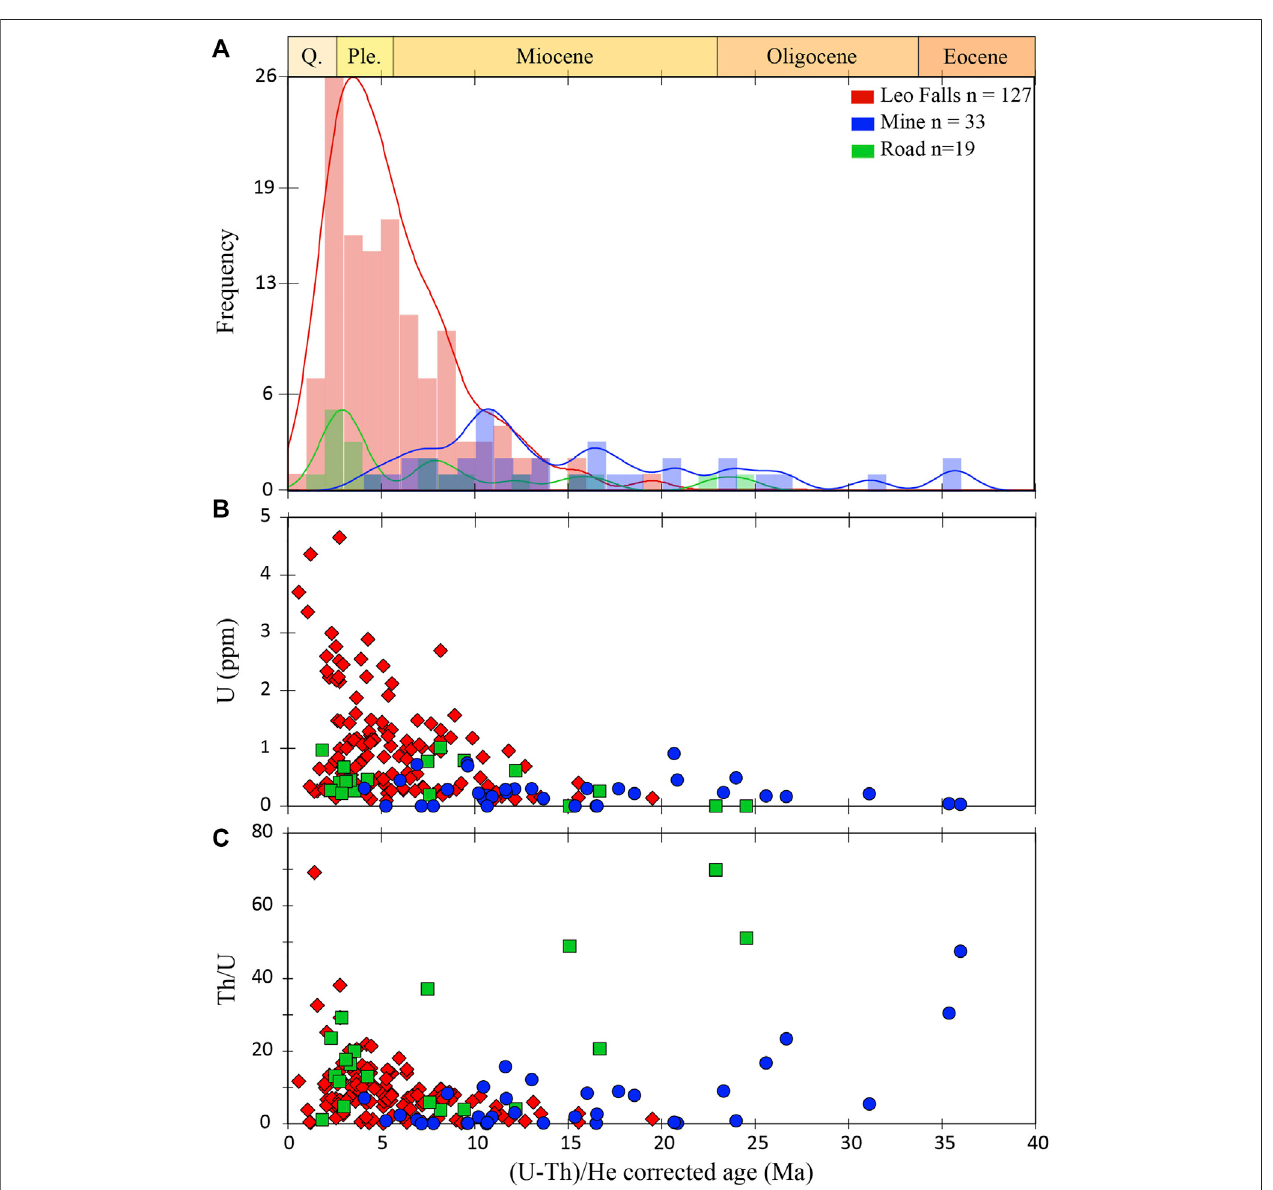
FIGURE6|(A) Fe-oxideagerepartitionineachsamplingsite.YoungFe-oxides(~3 – 5 Ma)arethemostcommon,especiallyatLeoFalls andintheRoadduricrust, and Fe-oxides older than Miocene are found in the Mine, with Q, Quaternary; Ple, Pleistocene; Eo, Eocene. (B) Evolution of the U concentration and (C) Th/U ratios of subsamples according to their (U-Th)/He